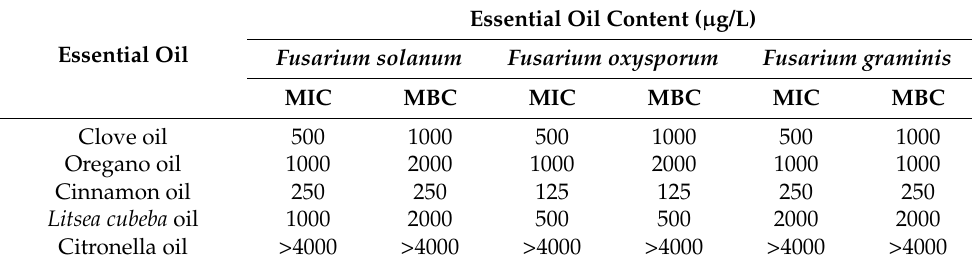
Table 3. MIC and MBC of five plant essential oils against three Fusarium